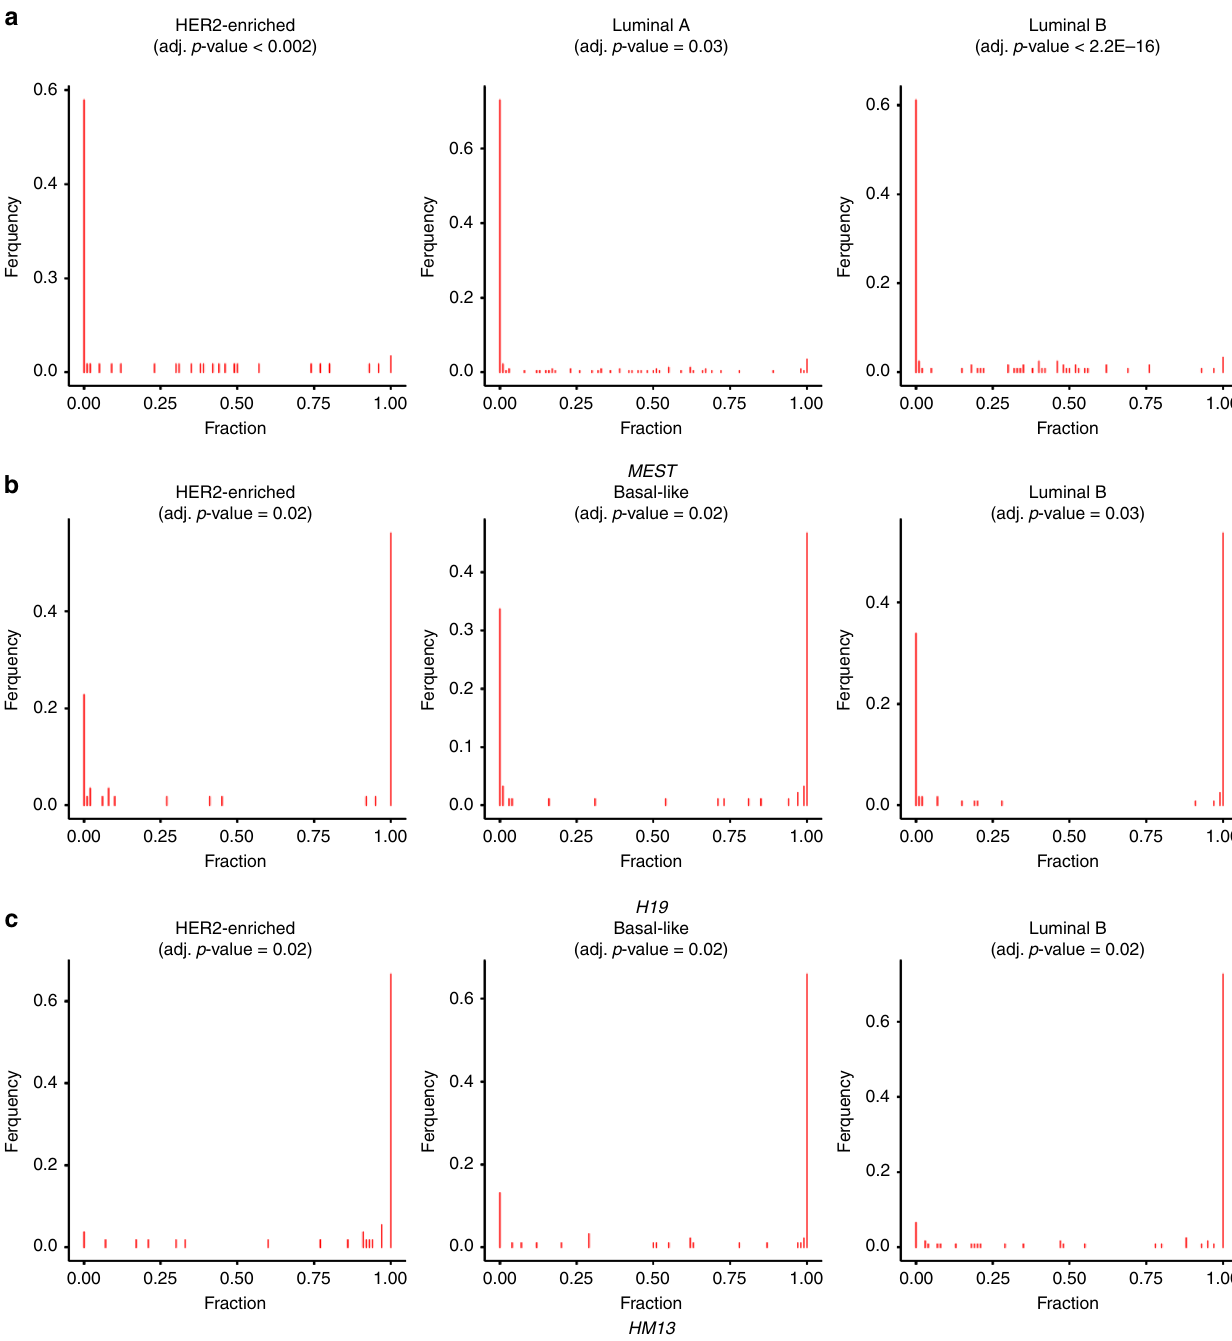
Fig. 3 SNP positions differentially imprinted between normal and cancer subtypes. a MEST (rs10863). b H19 (rs2839704). c HM13 among differentially methylated probes (Supplementary Data 3). These results suggest that imprinted gene silencing in breast cancer is common and often associated with CNV and deregulated methylation, and is the most likely cause of DI in cancer (rather than its consequence).